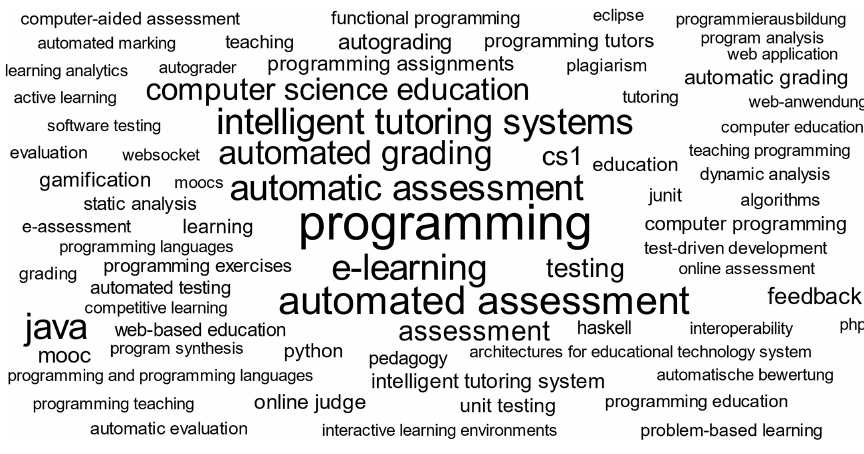
Fig. 2. Word cloud of the used index terms/keywords occurring at least three times (71